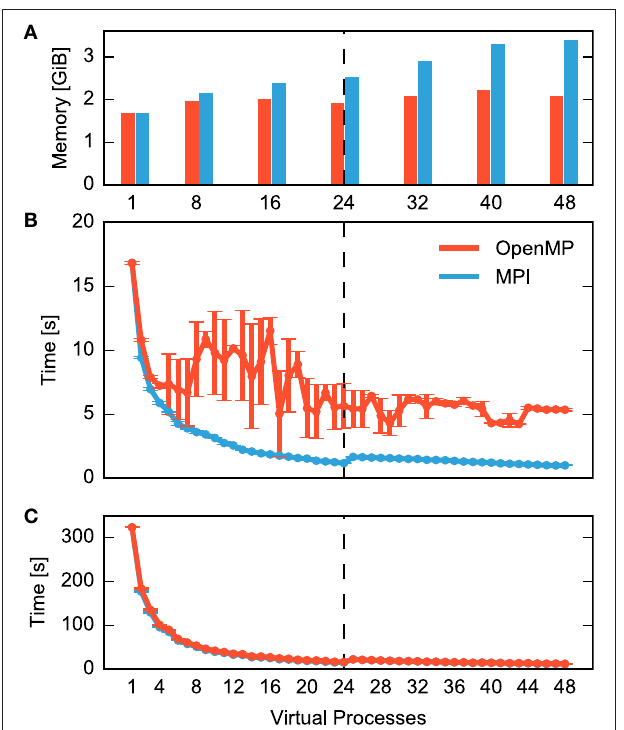
FIGURE 1 | Performance of a small neuronal network model on a single shared-memory compute node. A balanced random network model (Brunel, 2000) representing 25,000 neurons and 62.5 million synapses is simulated for one second of biological time (small benchmark). The compute node houses two CPUs with 12 cores each and up to two hardware threads per core. Table 1 summarizes the configuration. For detailed system specifications see Sections 2.2.1, and 2.2.2 for model specifications. (A) Memory consumption and (B) runtime of network construction as a function of the degree of parallelization. Red indicates parallelization using OpenMP threads and blue using MPI processes. Virtual processes first bind to cores on one CPU (up to 12 VPs), then on the second CPU (up to 24 VPs), and finally to the second hardware thread on each core (up to 48 VPs). The data are averages over five simulations with identical seeds of random number generators. Error bars in (B) show one standard deviation of measurements. (C) Runtime of the simulation of network dynamics, excluding the network construction phase shown in (B) . Same notation as in (B) . The dashed vertical line indicates the total number of physical cores of the compute node.